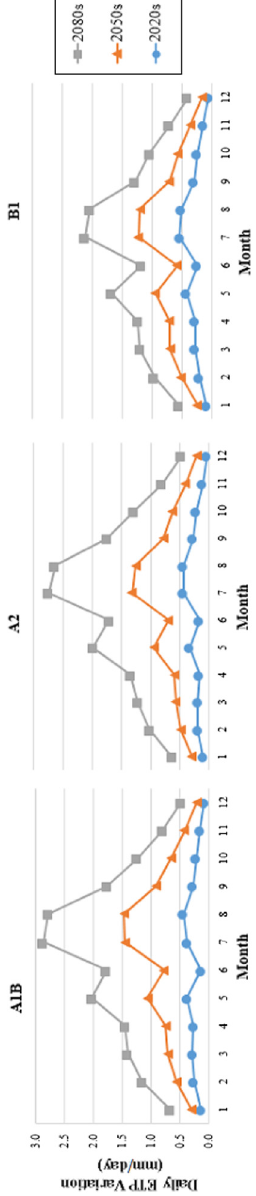
Figure 5. Daily ETP changes compared with the observed period